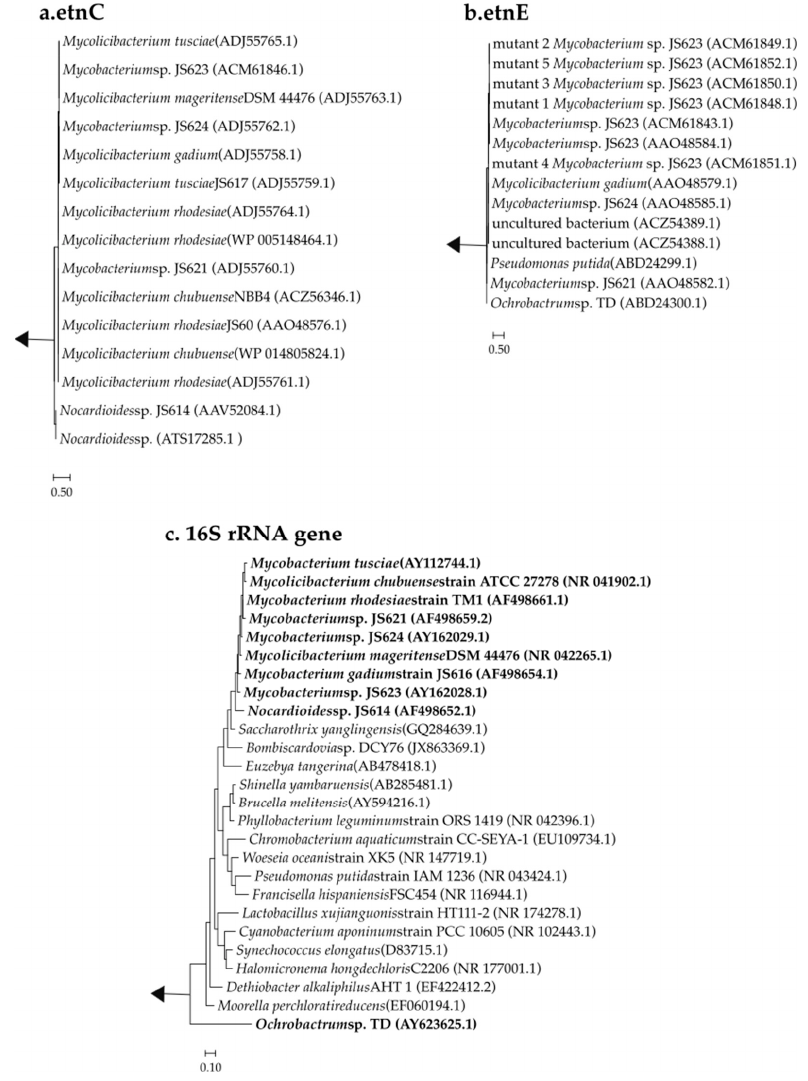
Figure 5. Phylogenetic trees of EtnC ( a ), EtnE ( b ), and 16S rRNA genes ( c ). Protein sequences found in the NCBI (National Center for Biotechnology Information) database through the BLASTp (Basic Local Alignment Search Tool protein in proteins) program based on the protein sequences of the enzymes EtnC and EtnE of Nocardioides sp. JS614 (accession numbers AAV52081.1 and AAV52084.1 on GenBank) were used. Branch length corresponds to the number of substitutions, and under each phylogenetic tree, the legend of the scale is reported. Sequences were analyzed with MEGA X soft- ware [77]. Sequence alignment was based on the Muscle algorithm [78], and phylogenetic trees were constructed using the Maximum Likelihood method with the JJT matrix model [79]. Sequences of methane monooxygenase were used as outgroups for the functional genes (WP_040789699, WP_005572960, MSQ68733, WP_083042312, WP_059039071 e WP_066161679), while Lactobacillus xujianguonis strain HT111-2 (NR_174278.1), Shinella yambaruensis (AB285481.1), Brucella melitensis (AY594216.1), Phyllobacterium leguminum strain ORS 1419 (NR_042396.1), Chromobacterium aquaticum strain CC-SEYA-1 (EU109734.1), Francisella hispaniensis FSC454 (NR_116944.1), Woeseia oceani strain XK5 (NR_147719.1), Bombiscardovia sp. DCY76 (JX863369.1), Saccharothrix yanglingensis